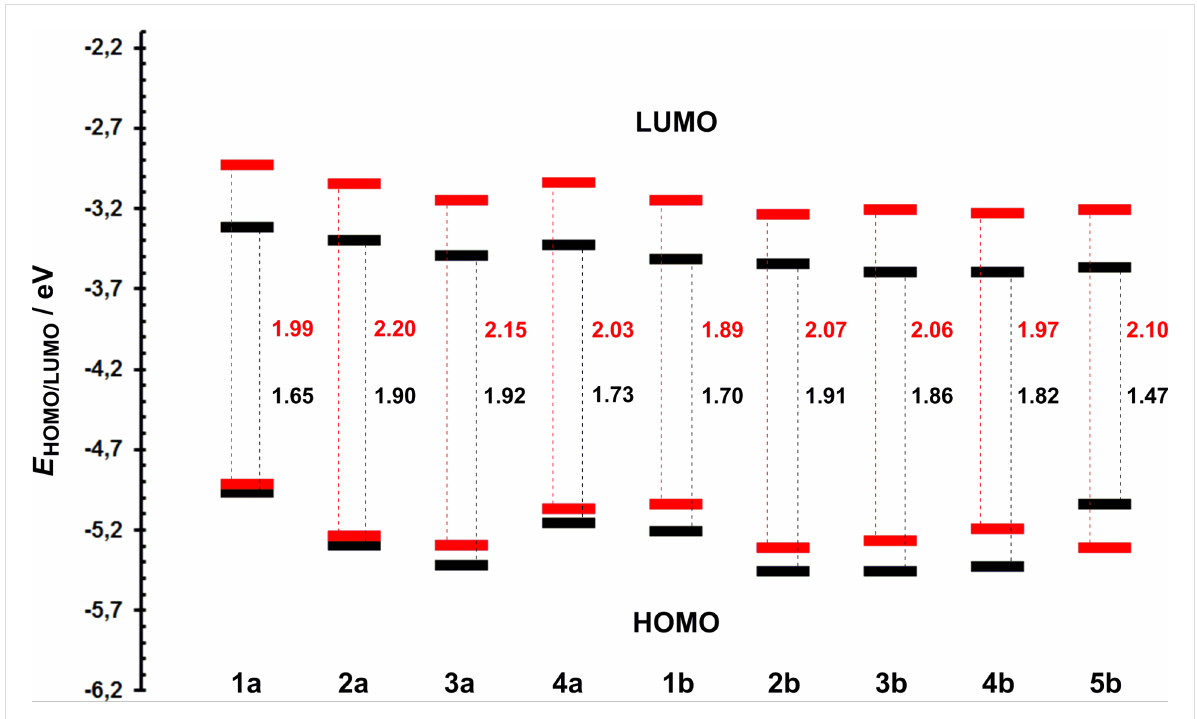
Figure 3: Energy level diagram of the electrochemical (black) and DFT (red) derived energies of the E HOMO/LUMO for chromophores 1 – 5 .